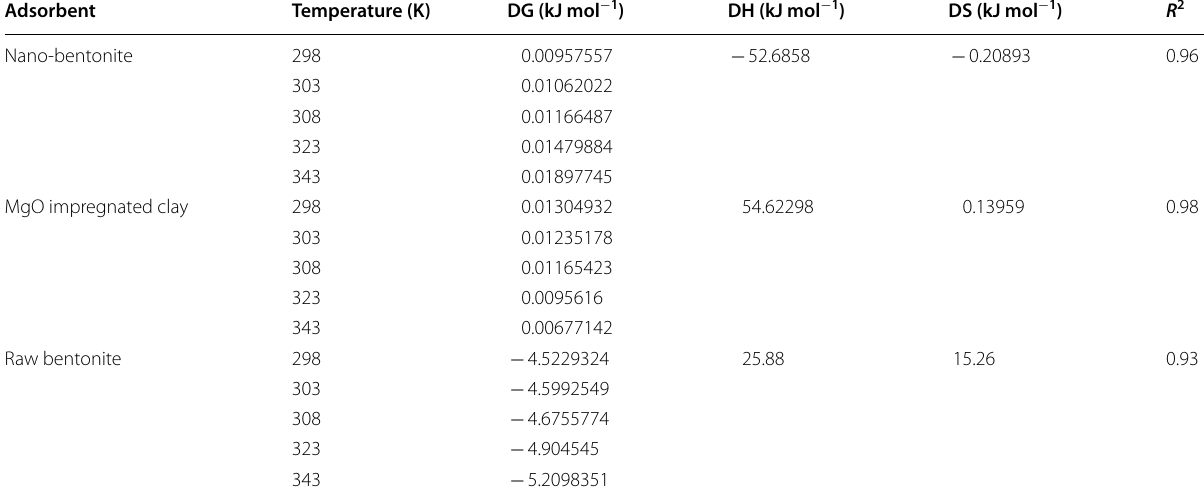
Table 6 Thermodynamic parameters of MG adsorption activity of nano-bentonite, MgO impregnated clay and raw bentonite